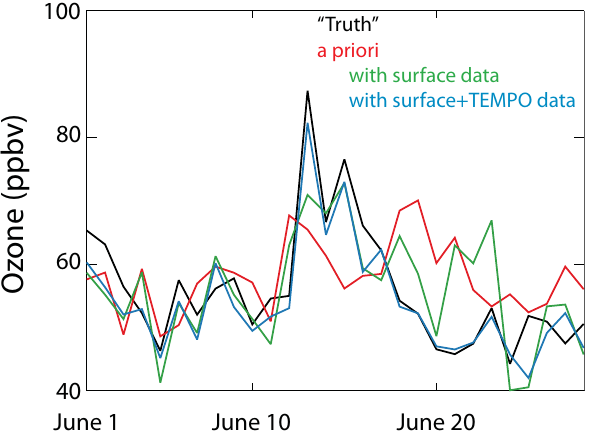
Figure 6. Detection of an exceptional ozone event by TEMPO. The figure shows the June 2010 time series of daily maximum 8h (MDA8) ozone concentrations at a location in northern New Mex- ico (107 ◦ W, 36 ◦ N) featuring a major stratospheric intrusion on 13 June in the GFDL AM3 model taken as the “truth” (black line). The ability to capture this event is examined for the GEOS-Chem model without data assimilation (a priori, red line) and with assim- ilation of surface measurements only (green line) and satellite mea- surements added (blue line).